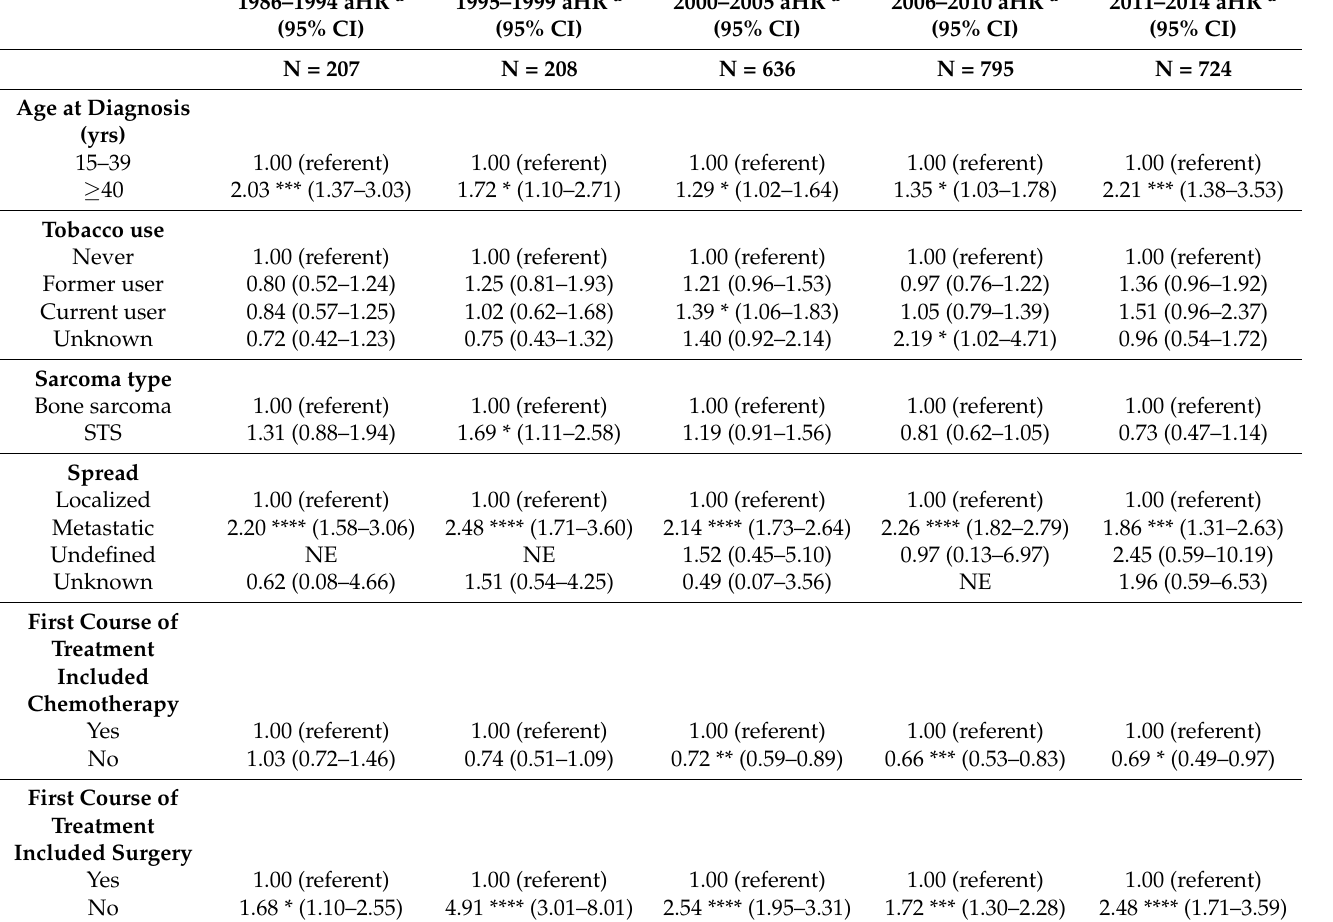
Table 3. Selected demographic and clinical characteristics in a multivariable model on overall survival in individuals diagnosed with sarcoma at MCC stratified by time period,